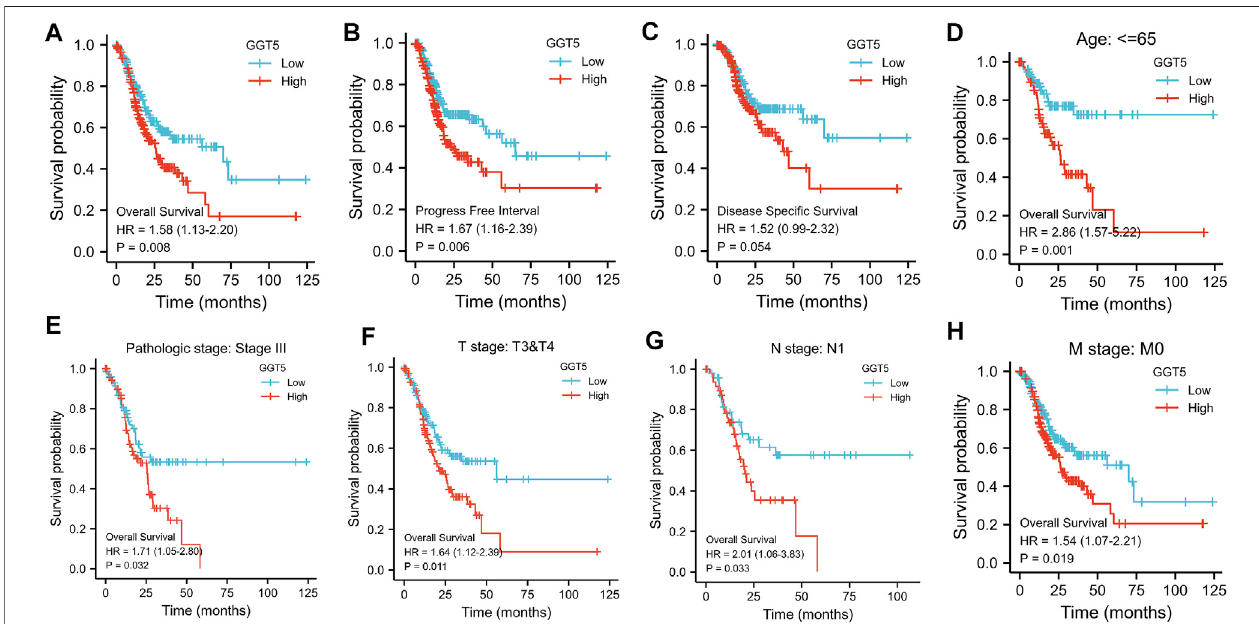
FIGURE 3 | Kaplan-Meier analysis of gastric cancer patients according to GGT5 expression level and subgroup analysis. The overall survival curves (A), progression-free interval curves (B) , and disease-speci fi c survival curves (C) between the GGT5 -high and GGT5 -low expression groups. (D – H) Comparison of the overall survival curves in age ≤ 65, pathologic stage III, T3 & T4 stage, N1 stage, and M0 stage subgroups between the GGT5 -high and GGT5 -low expression groups.